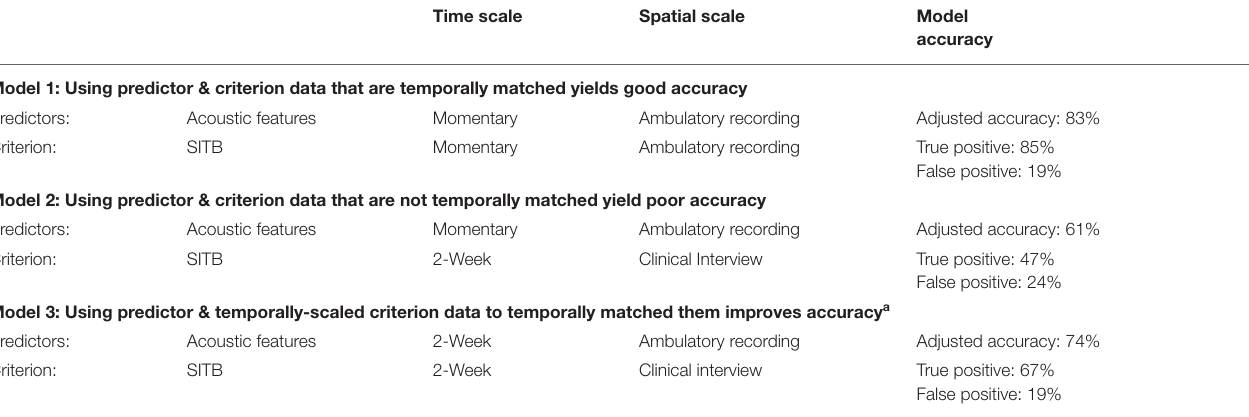
TABLE 3 | Modeling “momentary” and “2-week” self-injurious thoughts/behaviors based on “momentary” vocal features. Time scale Spatial scale Model